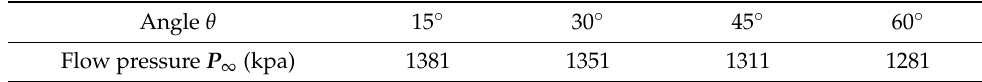
Table 8. Flow pressures with core thickness ration change. Table 10. Flow pressures with angle θ